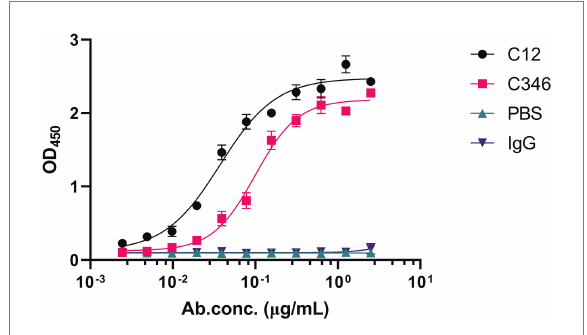
FIGURE 1 ELISA for detecting the binding ability of the purified anti-rPmt4p mAbs to C. albicans whole cells. Data are expressed as means ± SEM ( n =